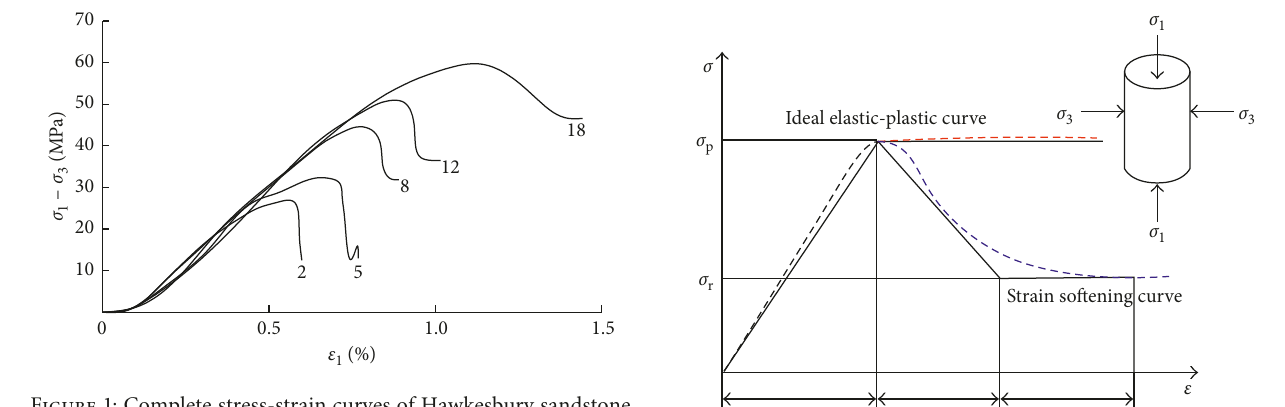
Figure 1: Complete stress-strain curves of Hawkesbury sandstone specimens under different confining stresses [18].